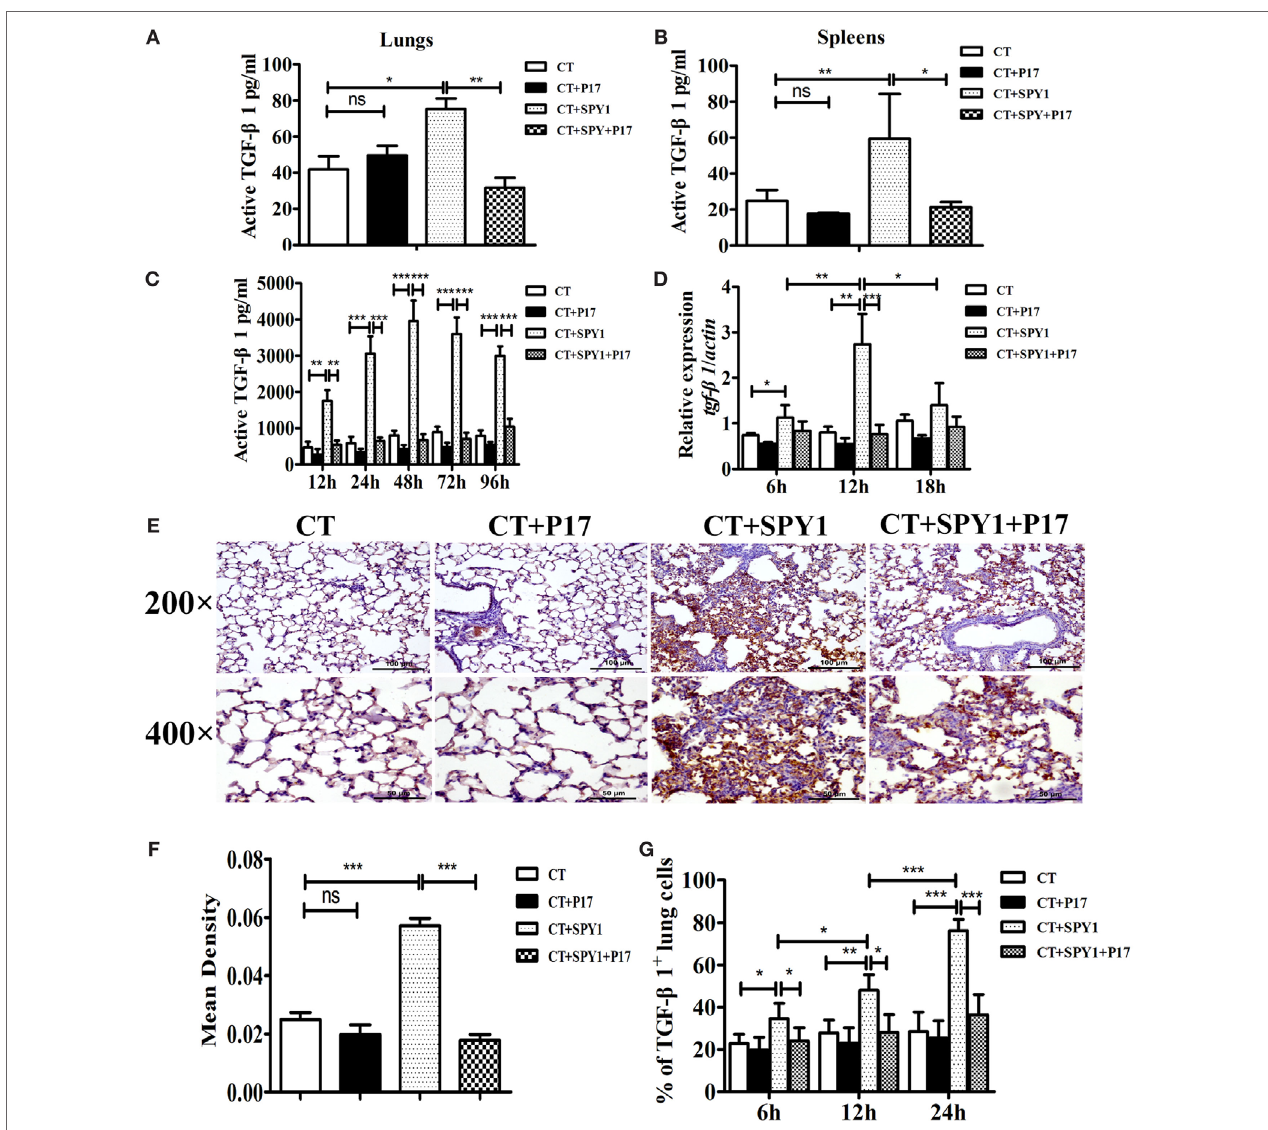
FigUre 5 | SPY1 vaccination stimulates the production of transforming growth factor β (TGF- β )1. On day 7 after the last immunization, mice were sacrificed and concentrations of active TGF- β 1 in lungs (a) and spleens (B) were determined by enzyme-linked immunosorbent assay (ELISA). (c) Splenocytes were isolated and stimulated with 70% ethanol-killed SPY1, and the level of active TGF- β 1 in splenocytes supernatants was also detected by ELISA. (D) Mice were intranasal challenged with 1 × 10 8 CFU of pneumococcal strain 19F on day 7 after the last immunization, and expression of tgf- β 1 mRNA in lungs were analyzed by quantitative real-time PCR at 6, 12, and 18 h post-infection, respectively. (e) At 24 h post-pneumococcal 19F infection, immunohistochemical staining with anti-TGF- β 1 polyclonal antibody was utilized to detect expression of TGF- β 1 in lung tissues. Lung sections were examined under light microscopy at magnification 200 × (scale bar = 100 µm) and 400 × (scale bar = 50 µm). (F) The mean IODs of TGF- β 1 expression were measured and calculated by Image-Pro Plus. Data were shown as mean ± SD of IODs of five mice per group. (g) Expressions of TGF- β 1 in mice lungs at 6, 12, and 24 h post 19F infection were determined by immunohistochemical staining, and percentages of lung cells with positive TGF- β 1 expressions were calculated by counting 100 cells of each lung section with three slides per time point (three mice per group). Data were shown as the mean ± SD from three independent experiments. * p < 0.05; ** p < 0.01; *** p <